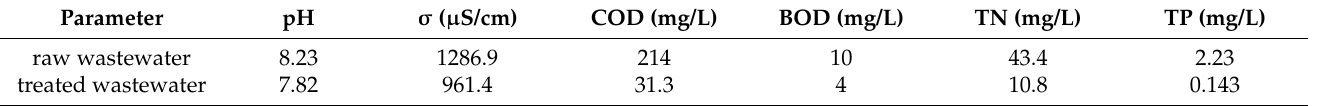
Table 6. Physicochemical indicators of the tested